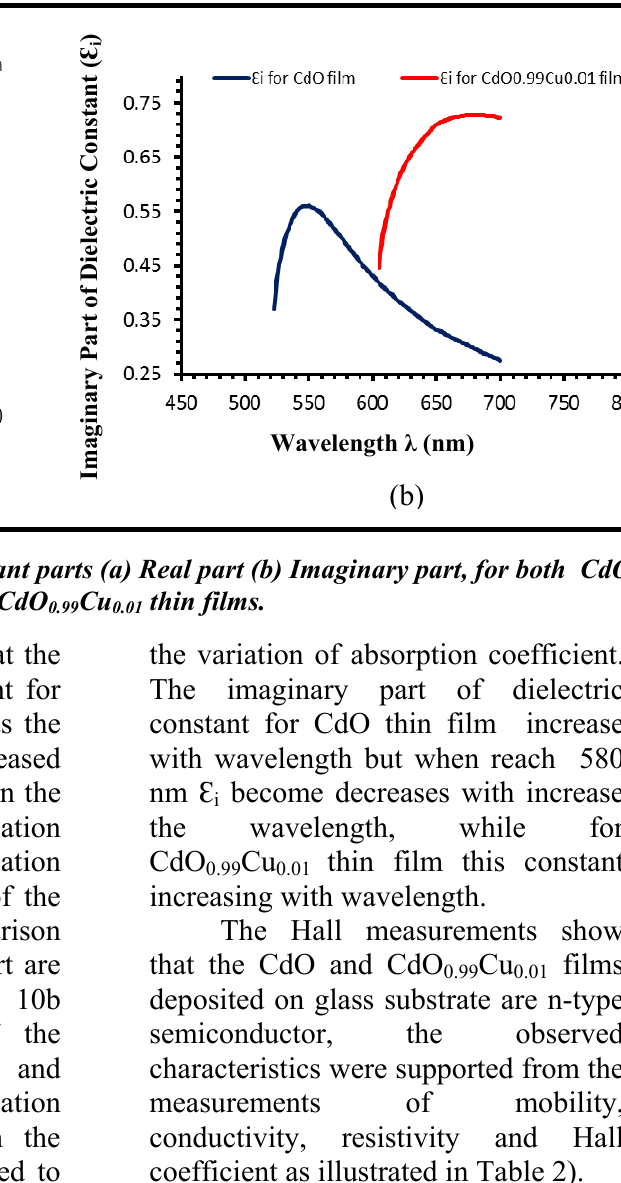
and CdO Cu thin 0.99 0.01